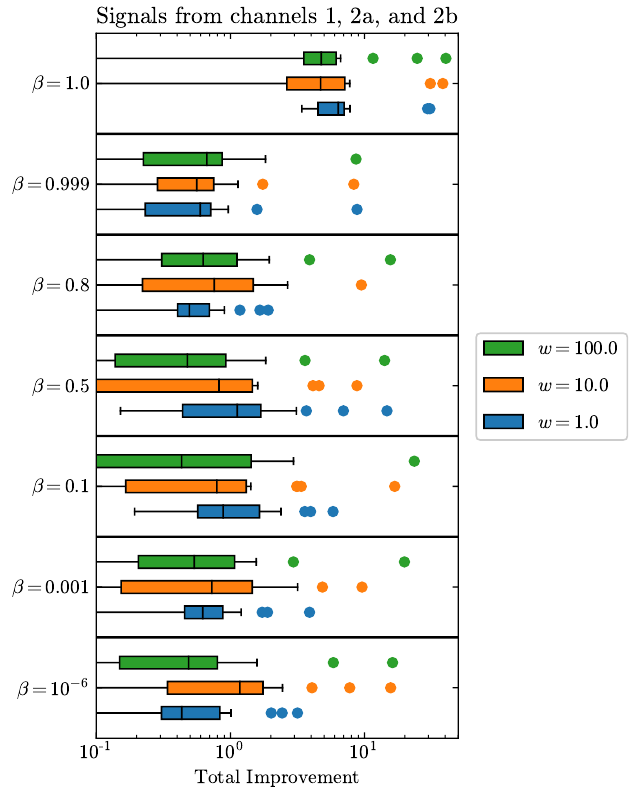
Figure 6: Distribution of total improvement scores from the signals of channels 1, 2a, and